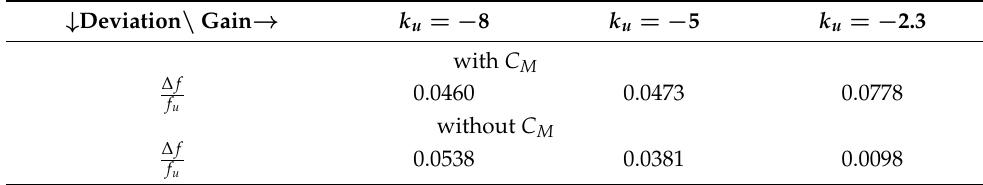
Table 2. Comparison of relative frequency deviations for optimum and non-optimum sets of inverter parameters both with and without the Miller capacitor for (cid:15) = 0.0029 ( r = 23mm). ↓ Deviation \ Gain